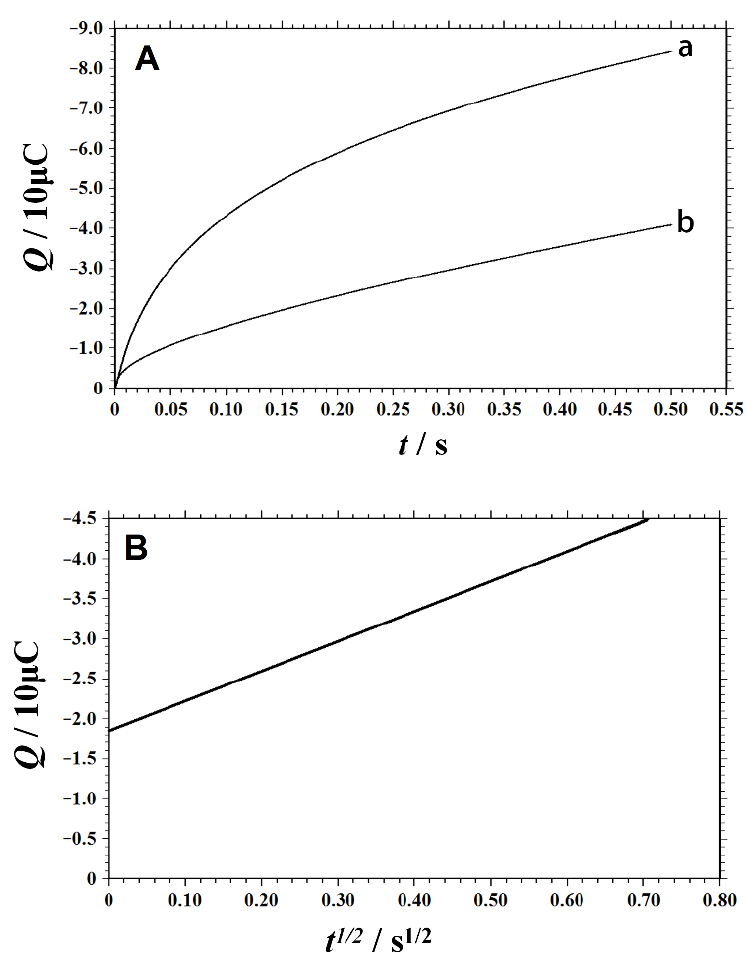
Figure 8. ( A ) Plot of Q – t curve of f-NC2/GCE in 0.2 M H 2 SO 4 solution containing 0.1 mM 4-NP (curve a). plot of Q – t 1/2 curve on the f-NC2/GCE (background subtracted, curve b). ( B ) stand for that in the blank solution.